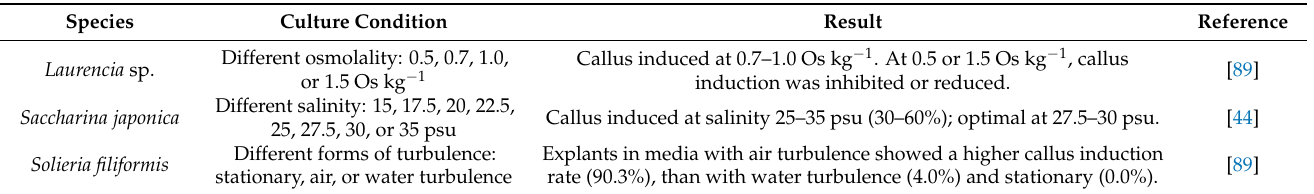
Table 6. Studies on the influence of salinity, osmolality, and turbulence on callus induction in seaweeds. Species Culture Condition Result Reference Laurencia